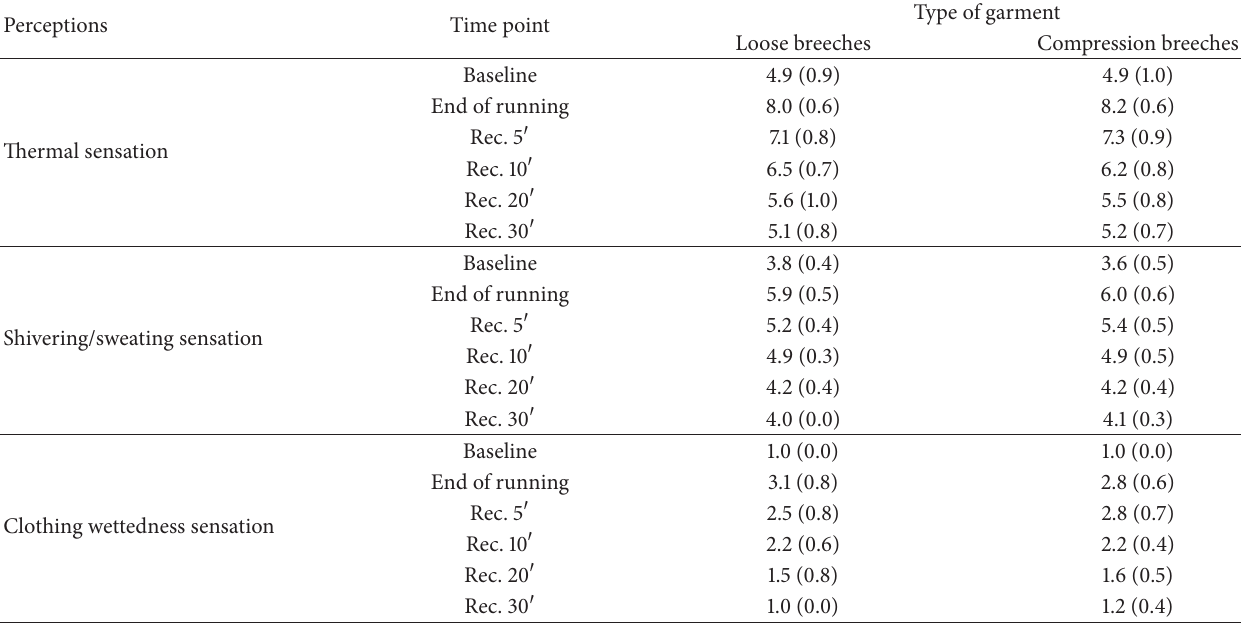
Table 5: Subjective ratings of perceptions in response to running in loose and compression breeches.